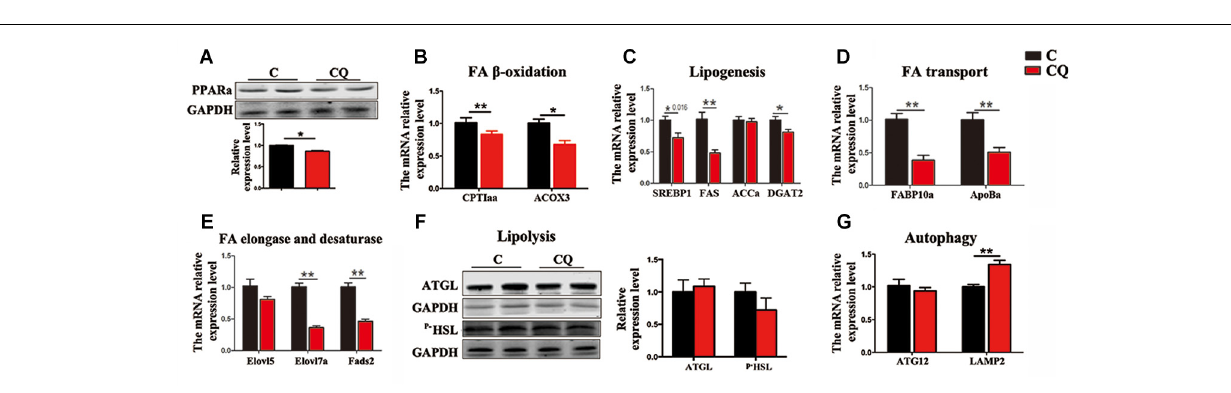
FIGURE 5 | Inhibited lipophagy suppresses expression of lipid metabolism-related genes and protein levels in ZFL cell line. (B–E,G) The mRNA expression of the genes related to lipid metabolism. (A,F) The protein levels of PPARa, ATGL and p-HSL. ∗ P < 0.05, ∗∗ P < 0.01, n = 6. Error bars,